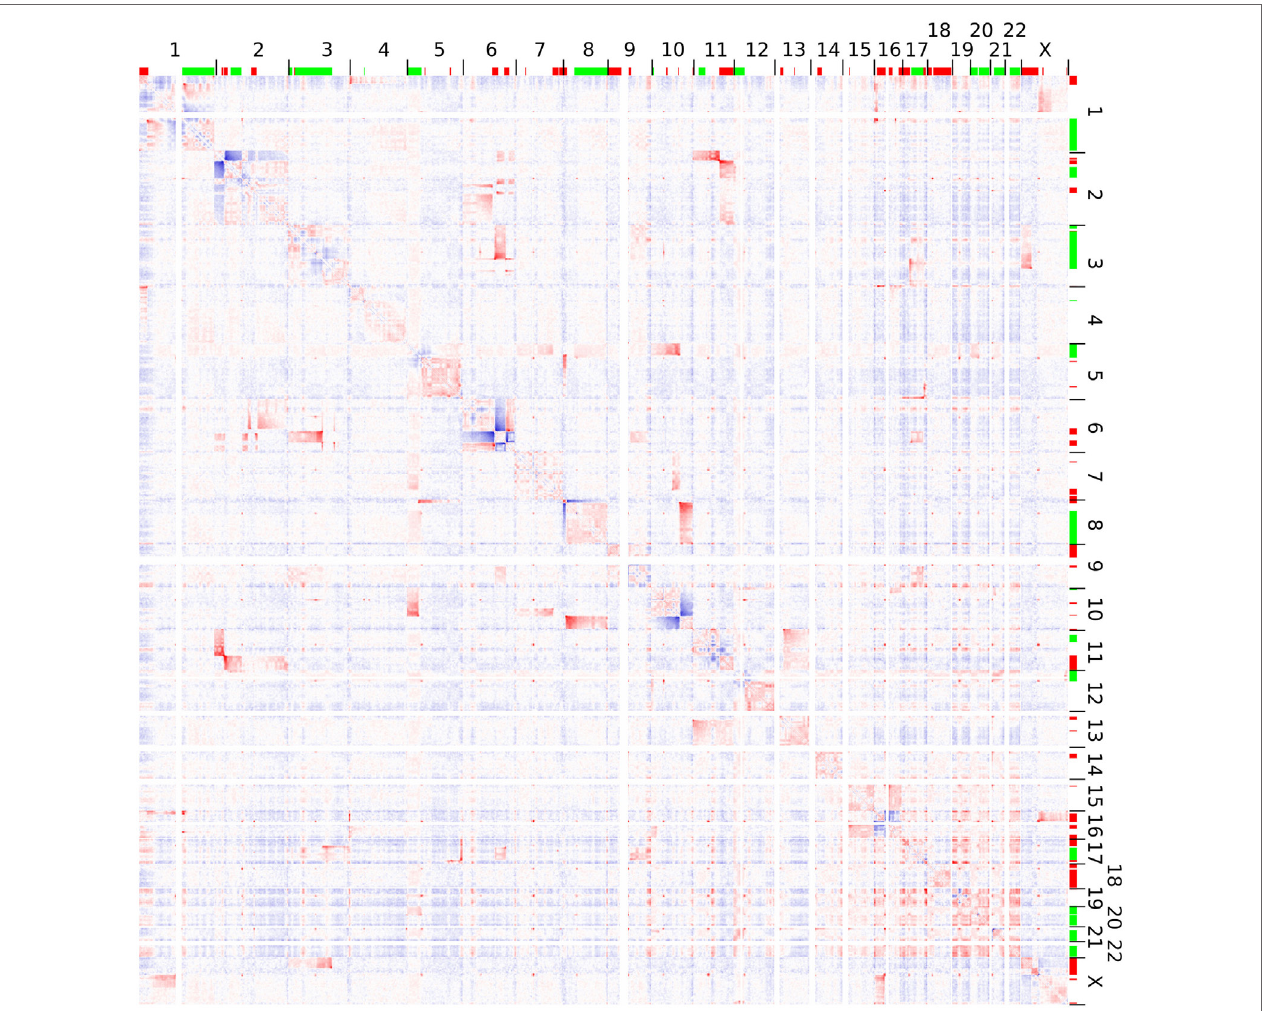
FigUre 2 | Genome-wide interaction frequencies in Se-Ax. Higher and lower than expected normalized interaction frequencies are shown with 2.5 Mb resolution in red and blue, respectively. The chromosome numbers are given at the top and to the right; together with information on DNA copy number losses (red) and gains (green) as detected by array comparative genomic hybridization. Translocations are characterized by interchromosomal interactions higher than expected, while their corresponding intrachromosomal interactions are decreased. A more detailed view of selected chromosomes is provided in Figure 3